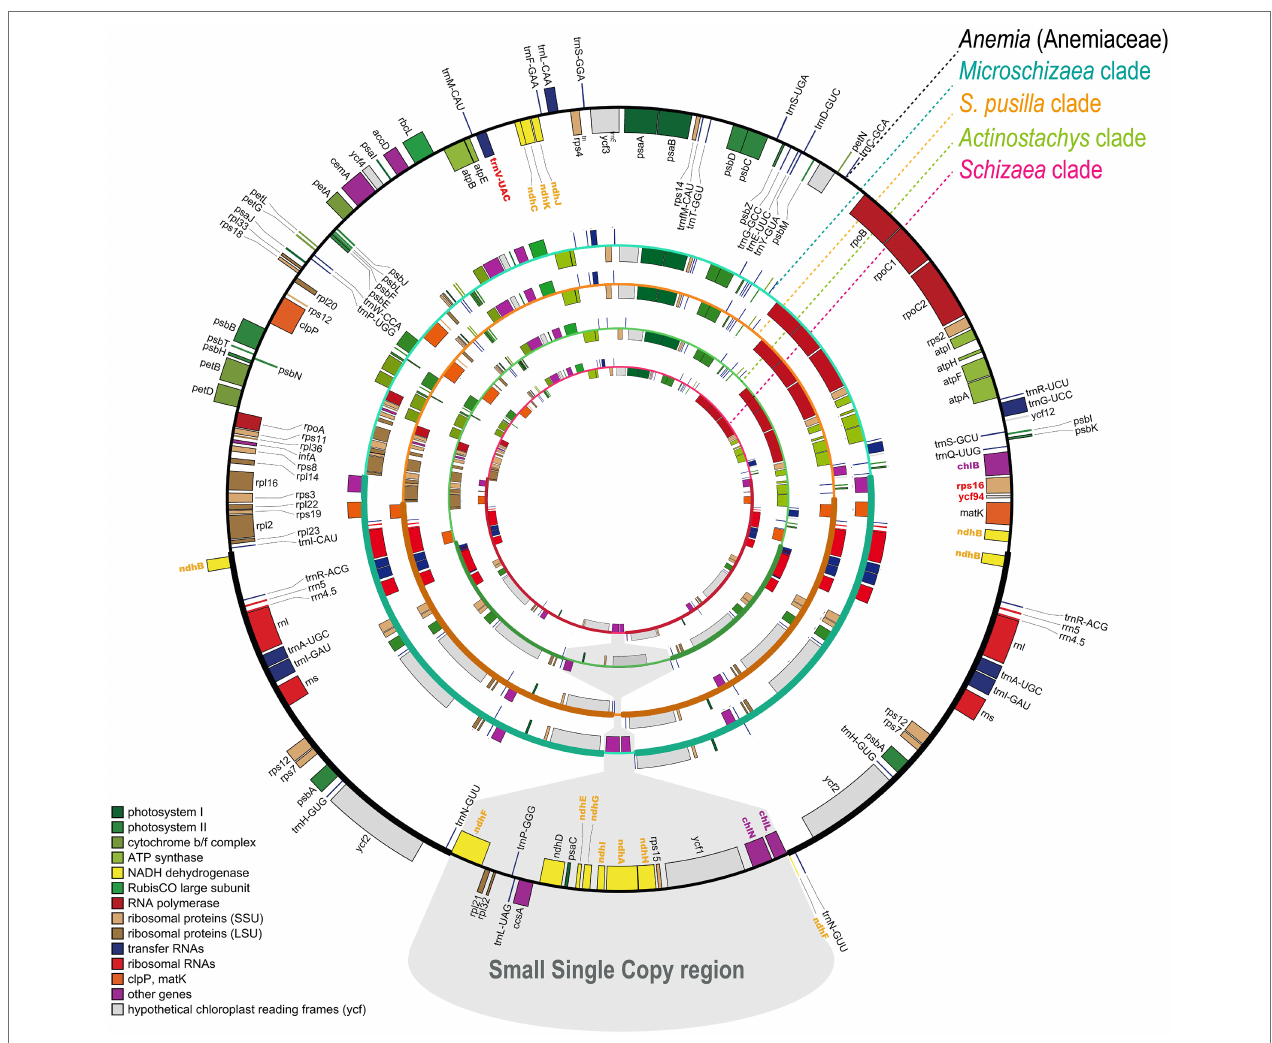
FIGURE 1 | The plastome maps of Schizaeaceae and Anemiaceae. The genes missing in Schizaeaceae plastomes have bolded and colored names. The maps are derived from OrganellarGenomeDRAW (Greiner et al., 2019).